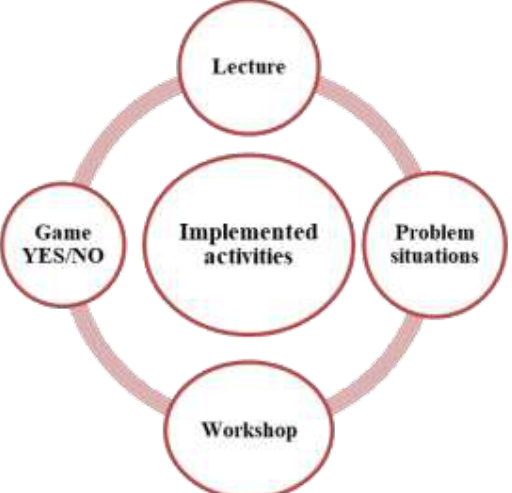
Figure 1. Schematic representation of implemented